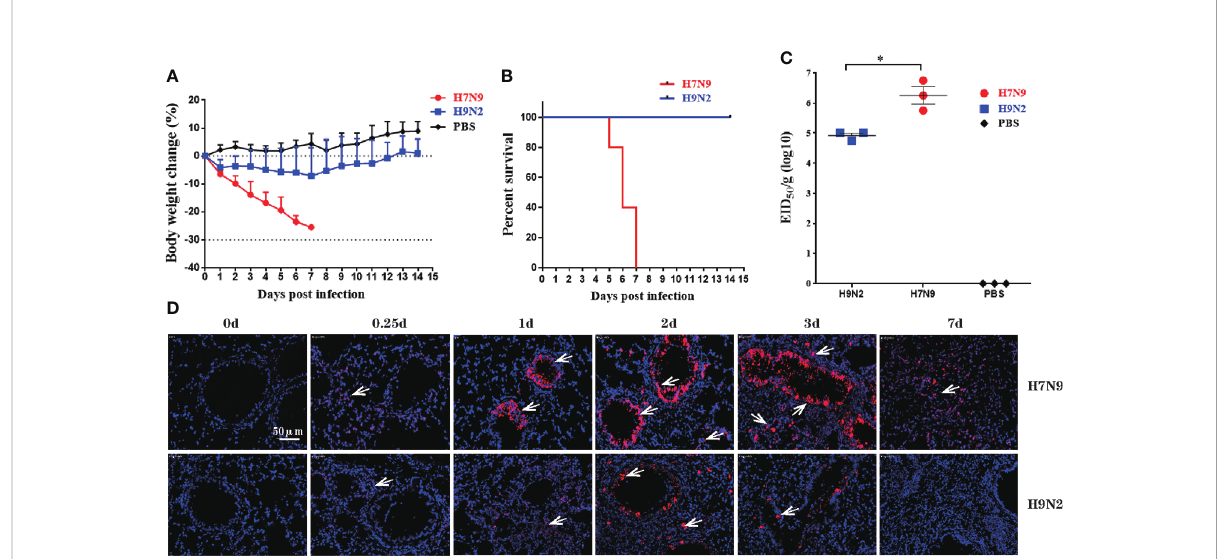
FIGURE 1 H7N9 virus is more virulent than H9N2 virus in C57BL/6 mice. Mice were intranasally inoculated with a single dose of 10 6 EID 50 of the H7N9 virus or the H9N2 virus. (A) Weight loss during a 14-day observation period. (B) Survival curve during a 14-day-observation period. Mice that lost >30% of their pre-inoculated weight were regarded as dead and euthanized. (C) Virus titers in mice lungs, as determined by EID 50 using MDCK cells. (D) Representative images of RNAscope in situ hybridization (ISH) showing virus NP expression in lung. Each red dot represents a single NP RNA molecule, further indicated by white arrow, with nuclei counterstained by DAPI. Data are expressed as mean ± SEM.*P < 0.05 by one-way